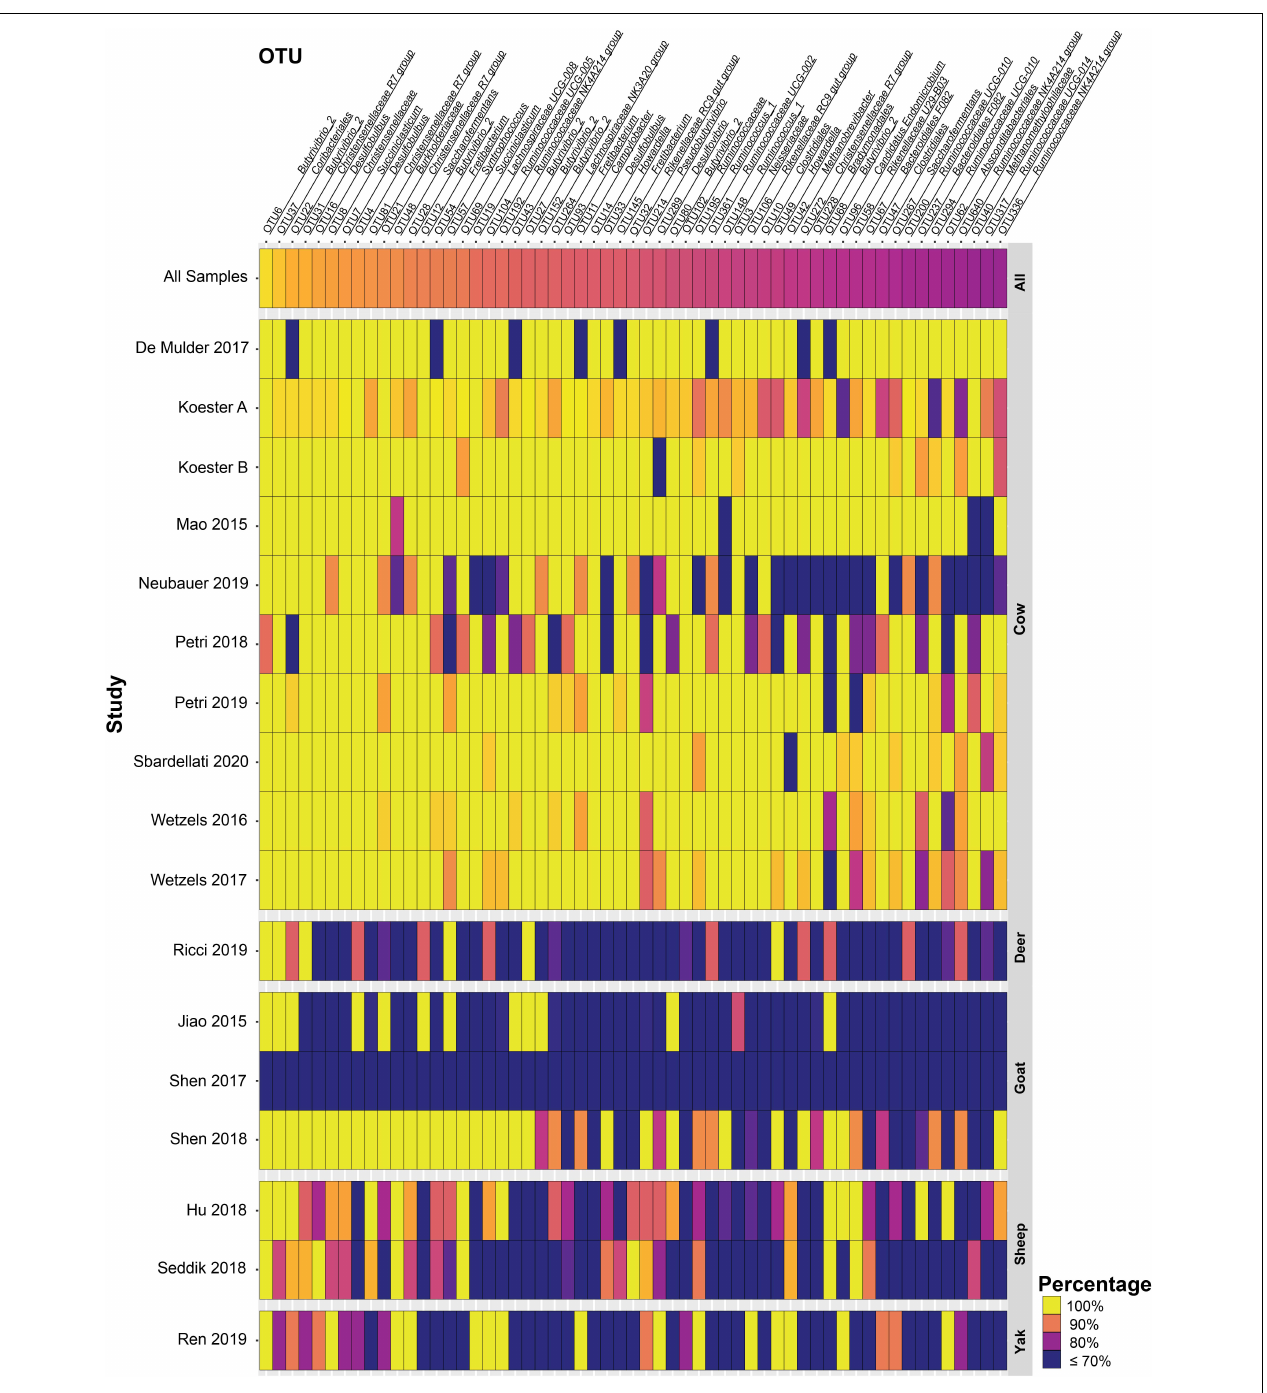
FIGURE 2 | Heat map of 57 core rumen epithelial OTUs (OTUs present in ≥ 80% of samples after closed-reference clustering) showing OTUs shared between different studies. The color represents the percentage of samples in a study that contain the respective OTU. The percentage across all samples is represented at the top, and studies are sorted by animal. Values less than 70% have been truncated to 70% for greater resolution of high values. See Supplementary Table 1 for more details on the studies.